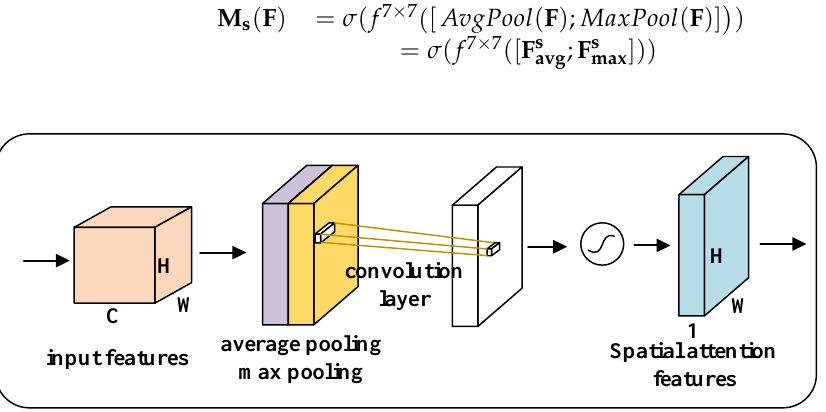
Figure 8. Spatial attention mechanism.